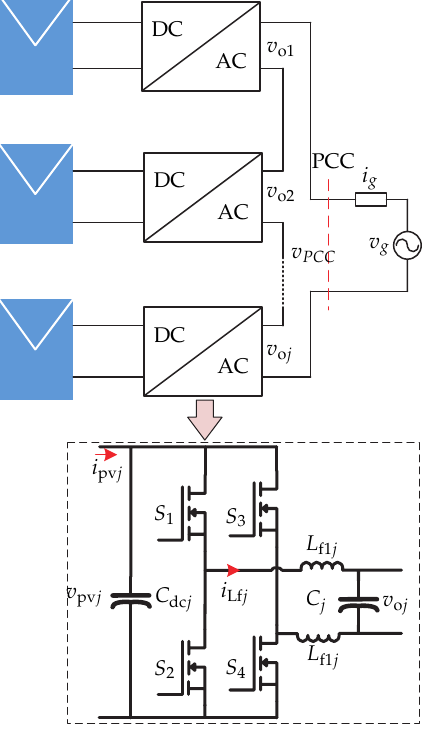
Figure 28. Microinverter’s topology proposed in [65].